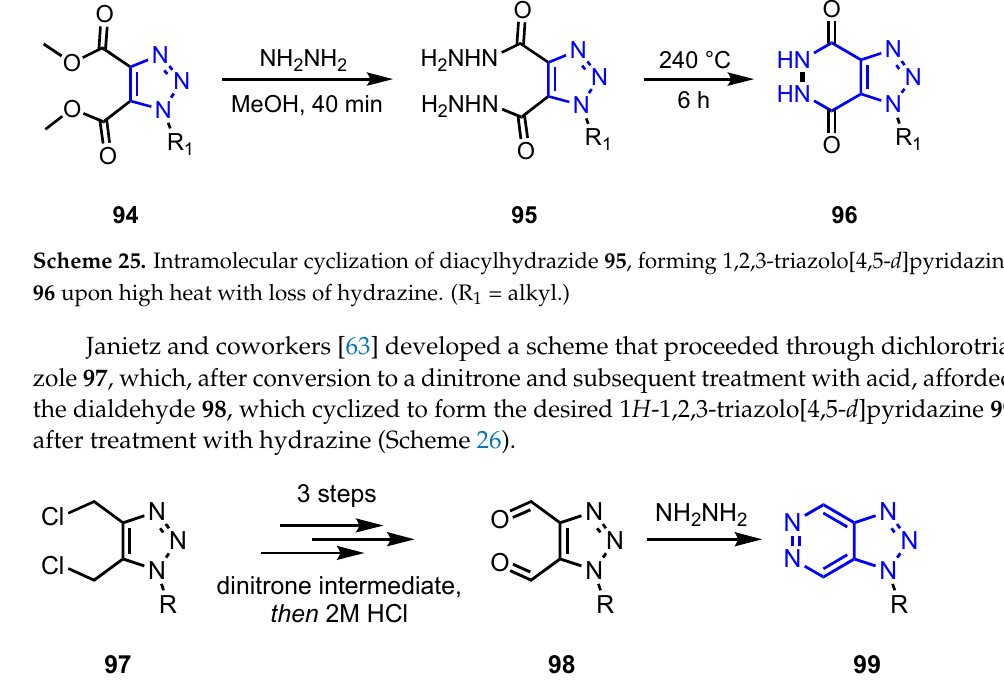
Scheme 26. Synthesis of substituted 1,2,3-triazolo[4,5- d ]pyridazines 99 from 4,5-dichloromethyltriazoles 97 , proceeding through dialdehyde 98 . (R = aryl.)